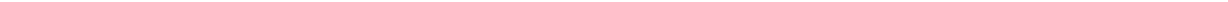
Fig. 1 PKD activity regulation in an in vitro model of NMDA-induced excitotoxicity. a Scheme showing activatory and autophosphorylation sites and domains in PKD1. b p-PKD(S916), p-PKD(S744/S748), PKD, p-DAPK(S308), DAPK, and Spectrin immunoblot analysis of primary mature cortical